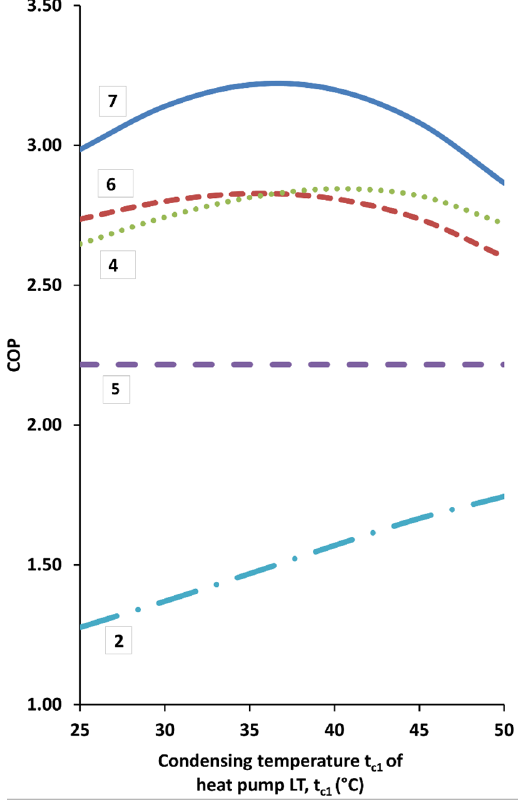
Figure 13. Comparison of COP